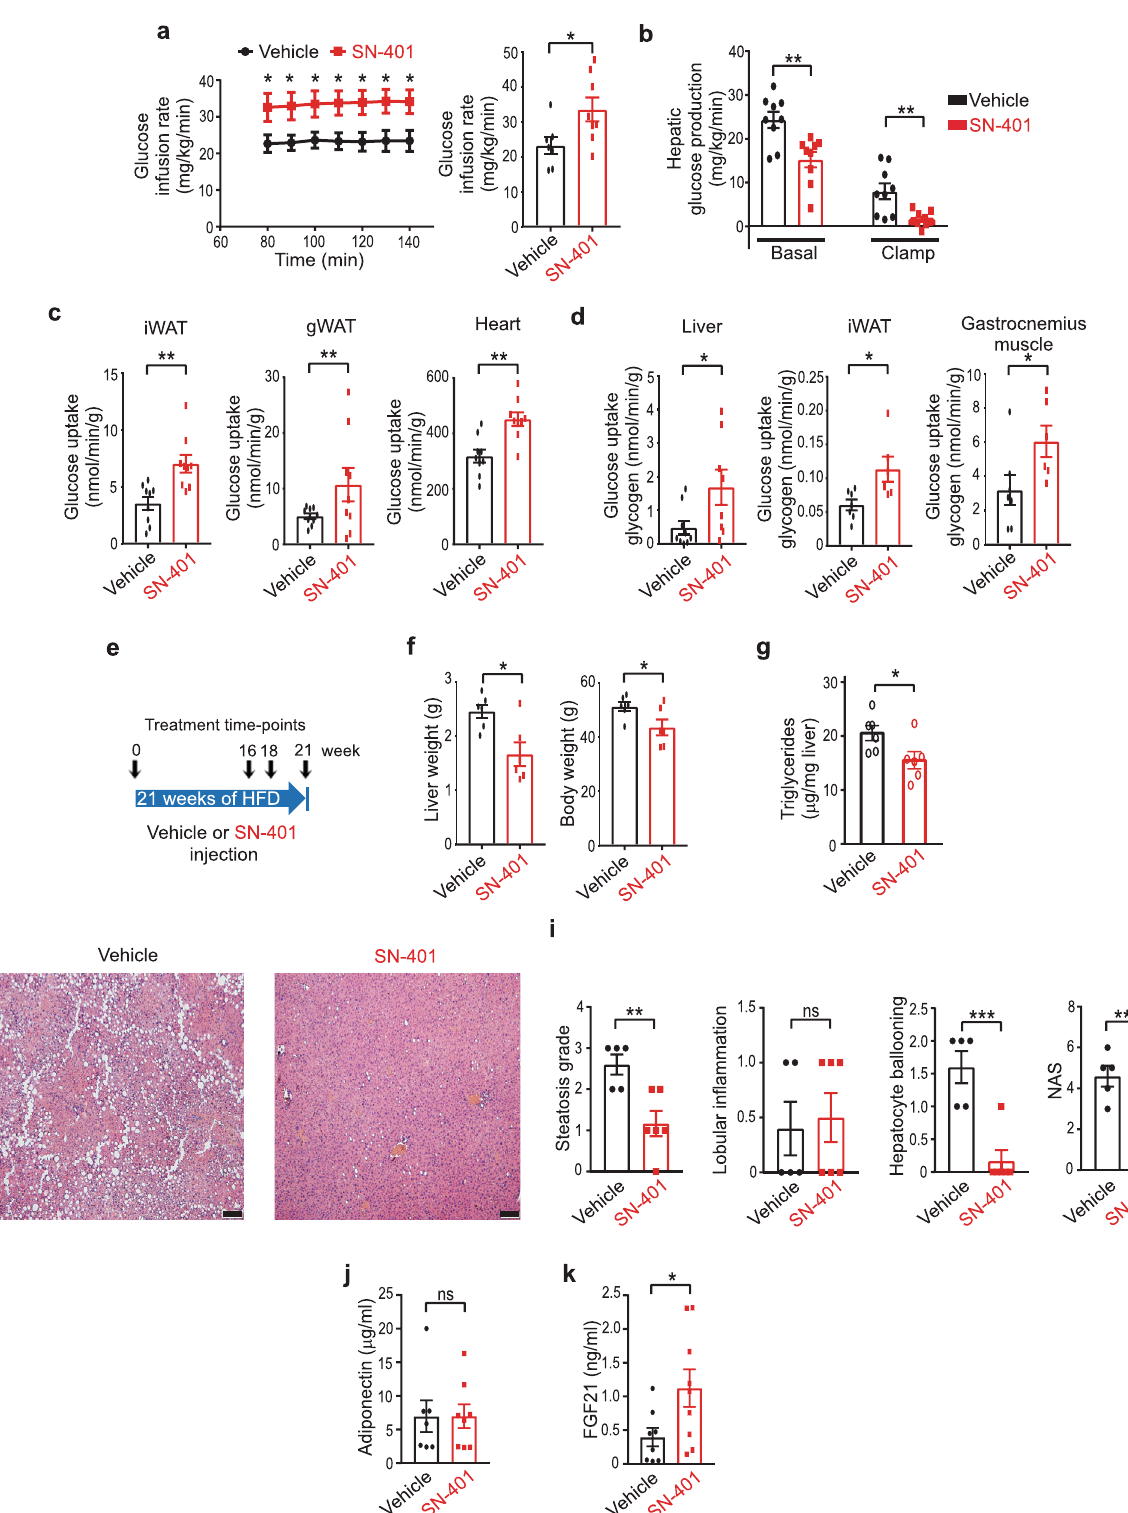
its cyclopentyl group closer to the hydrophobic cleft between SWELL1 subunits (Fig. 7b). These data con fi rm lengthening the carboxylate chain in SN-407 preserves electrostatic interactions with R103 and enables additional contacts between the carboxylate chain and upper hydrophobic moieties in distinct binding poses, consistent with the results of our docking simulations. We note that while these models represent the